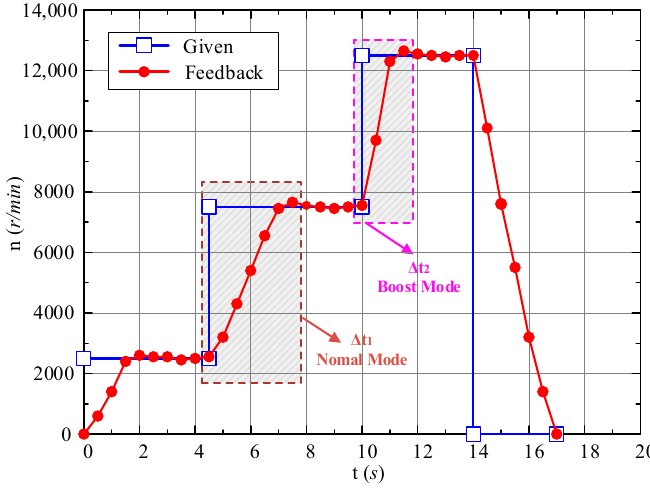
Figure 12. Speed tracking curve.